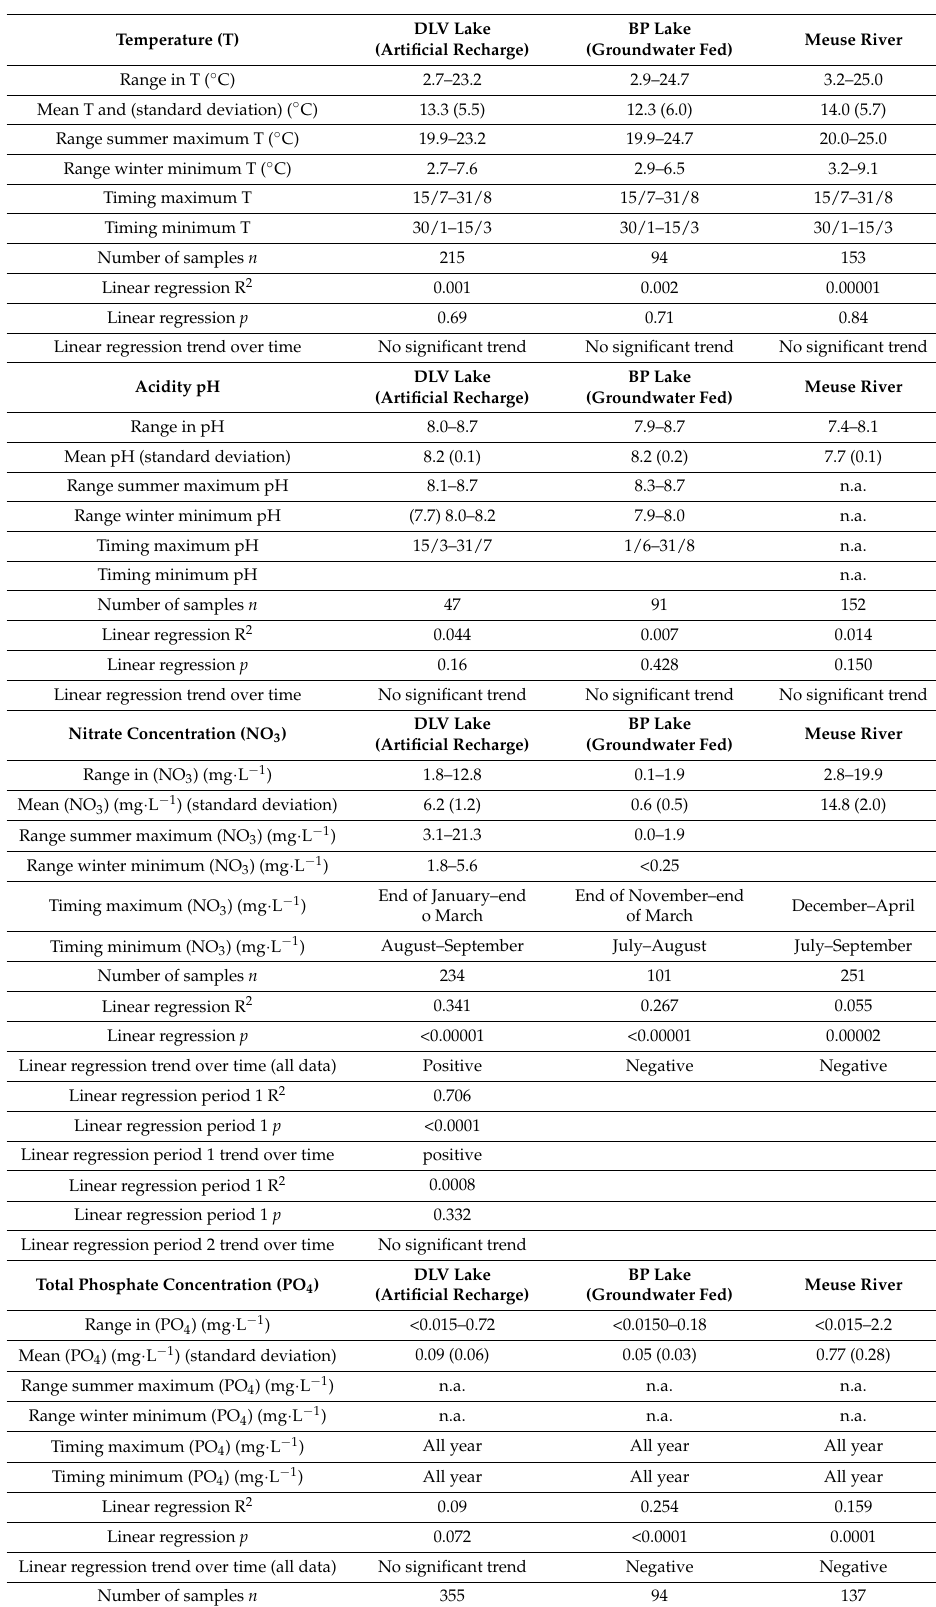
Table 2. Statistics for temperature, pH, NO 3 PO 4 and SO 4 concentration in gravel pit lake with artificial recharge (DLV Lake), groundwater-fed only (BP Lake) and River Meuse water. ‘n.a.’ stands for ‘not